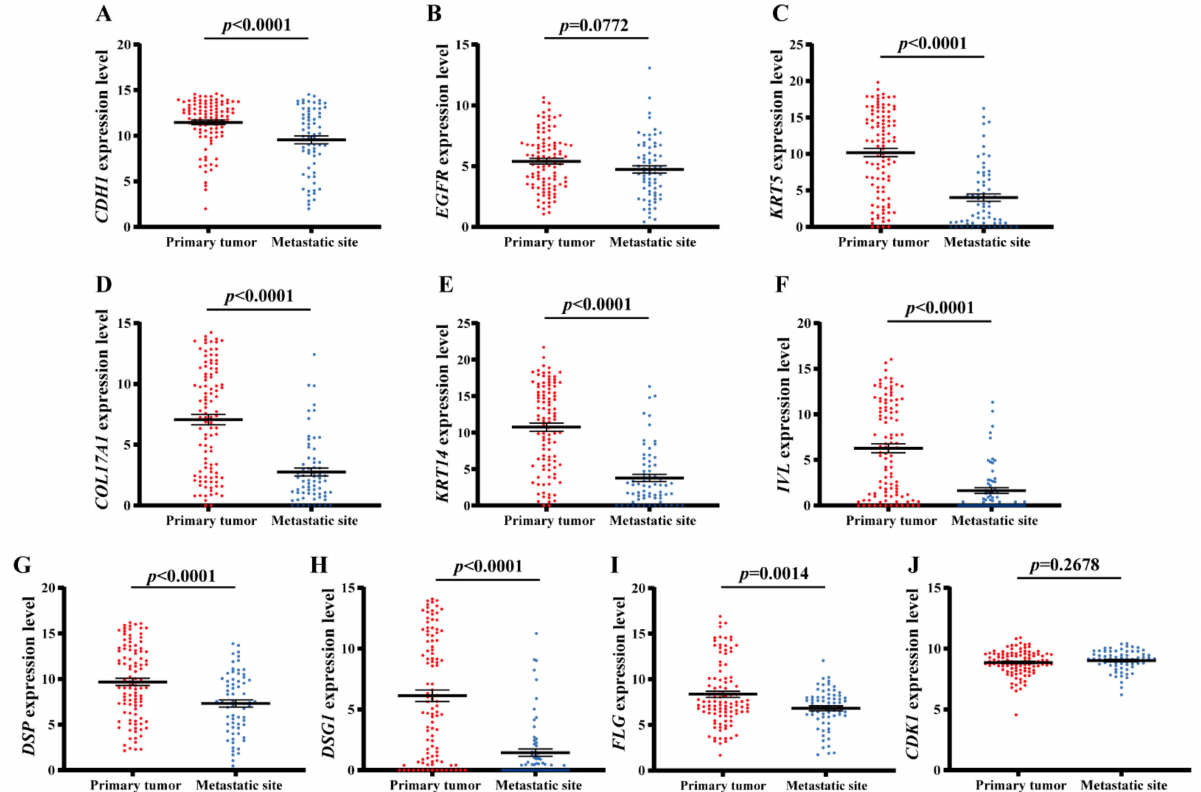
Figure 4. Expression levels of hub genes in melanoma metastases ( n = 71) and primary melanoma ( n = 105) visualized through the TCGA database. Histograms represents the expression levels of ( A ) CDH1 , ( B ) EGFR , ( C ) KRT5 , ( D ) COL17A1 , ( E ) KRT14 , ( F ) IVL , ( G ) DSP , ( H ) DSG1 , ( I ) FLG , and ( J ) CDK1 . p value < 0.05 was considered significant, t -test.